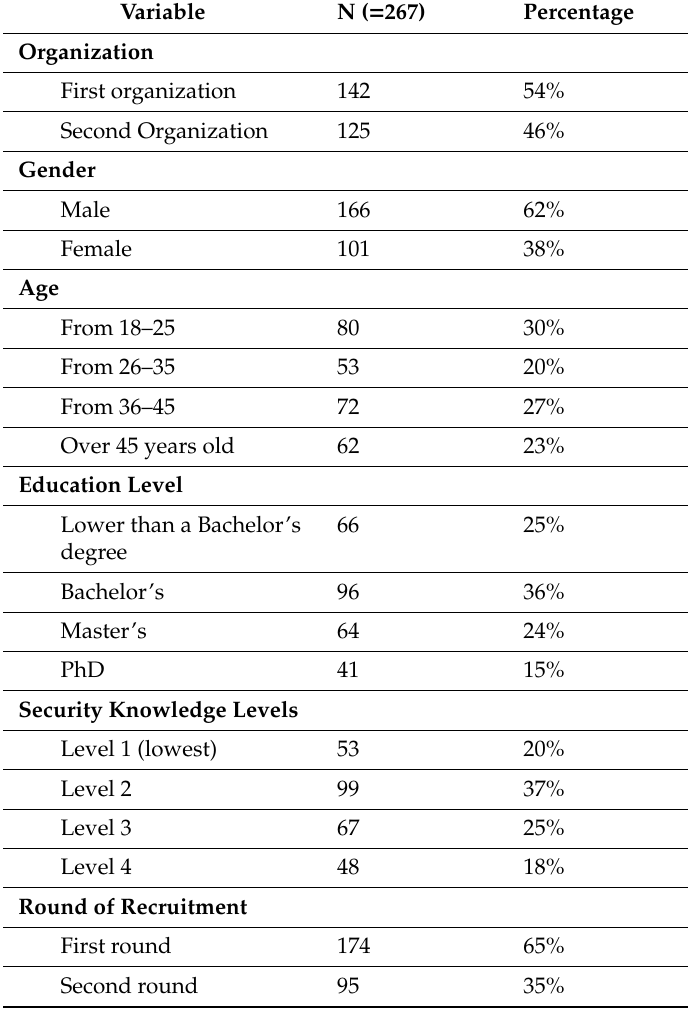
Table 3. Demographics of the